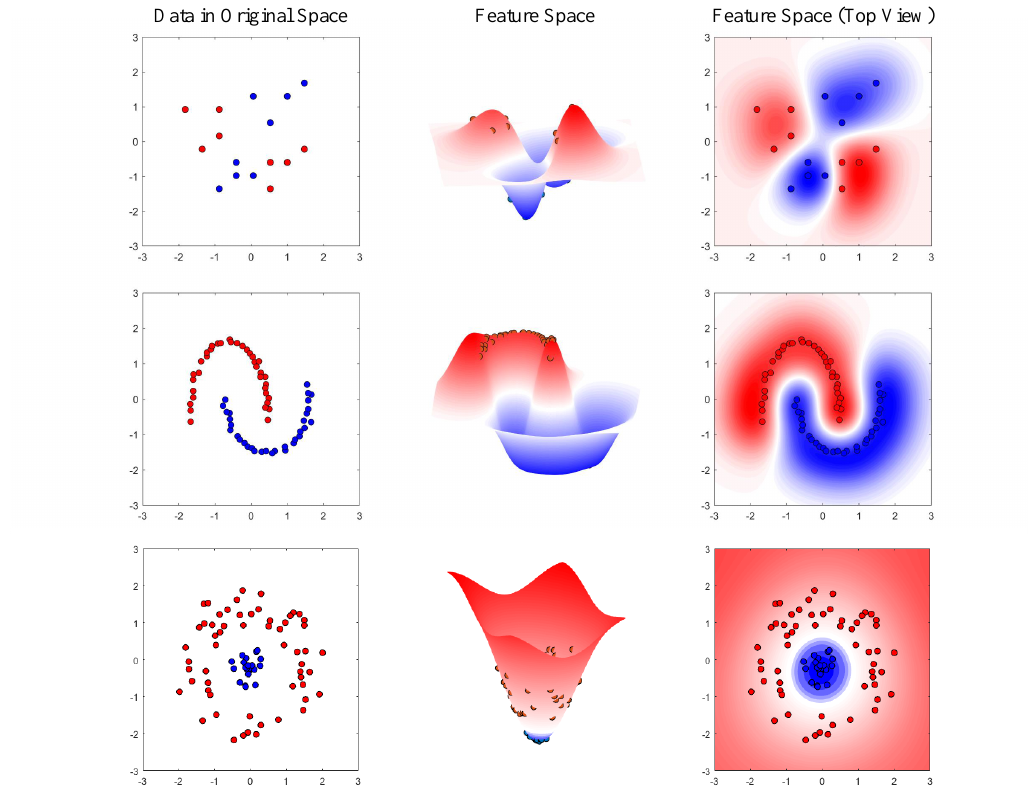
Figure 3. Illustration of kernel nonlinear transformation. These were generated with code available in